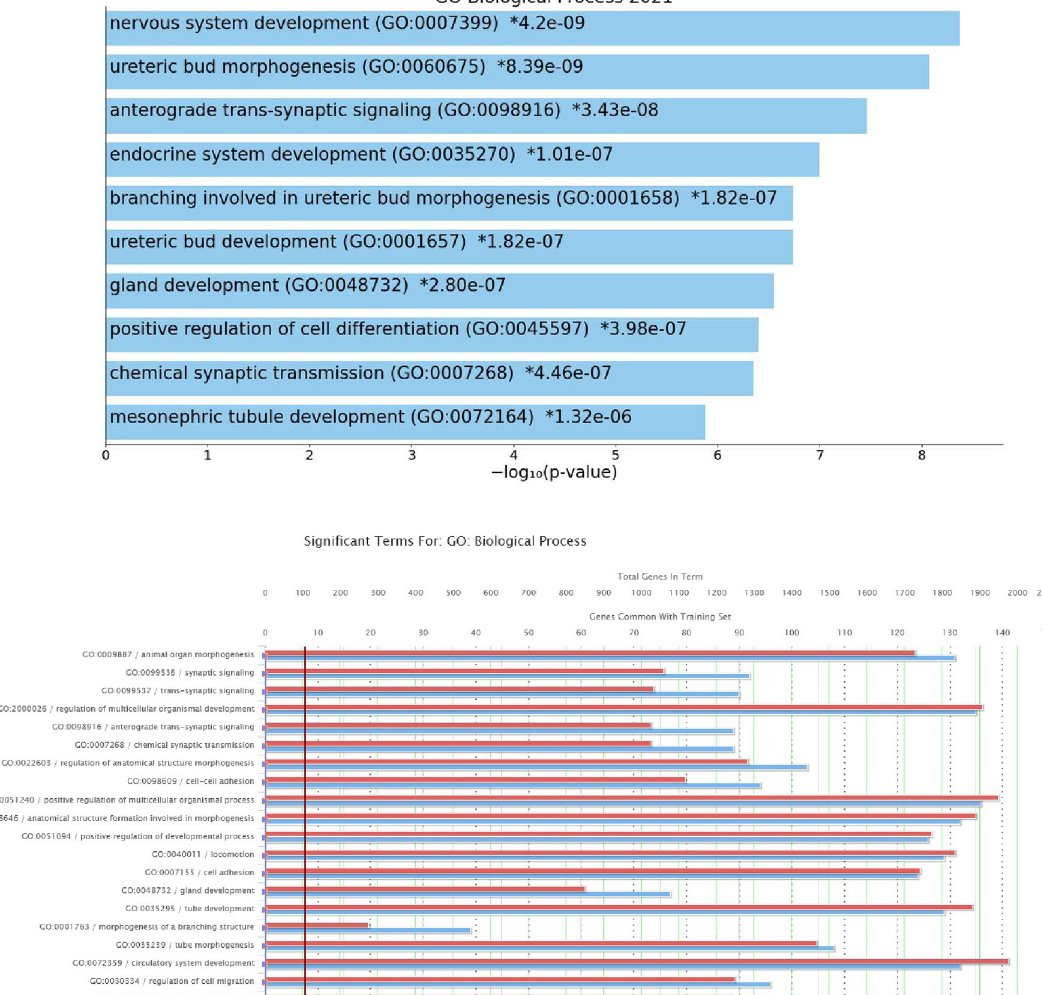
PLOS ONE | https://doi.org/10.1371/journal.pone.0270380 January 23,